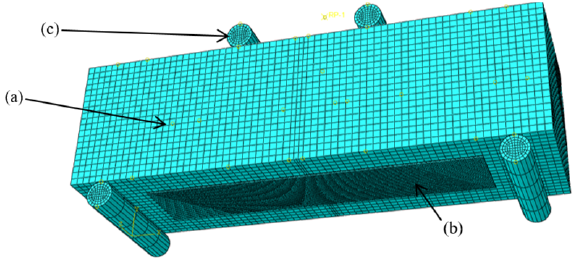
Fig. 6. Mesh of (a) concrete beam, (b) CFRP plates and epoxy-resin, and (c) rigid for supports and punches.